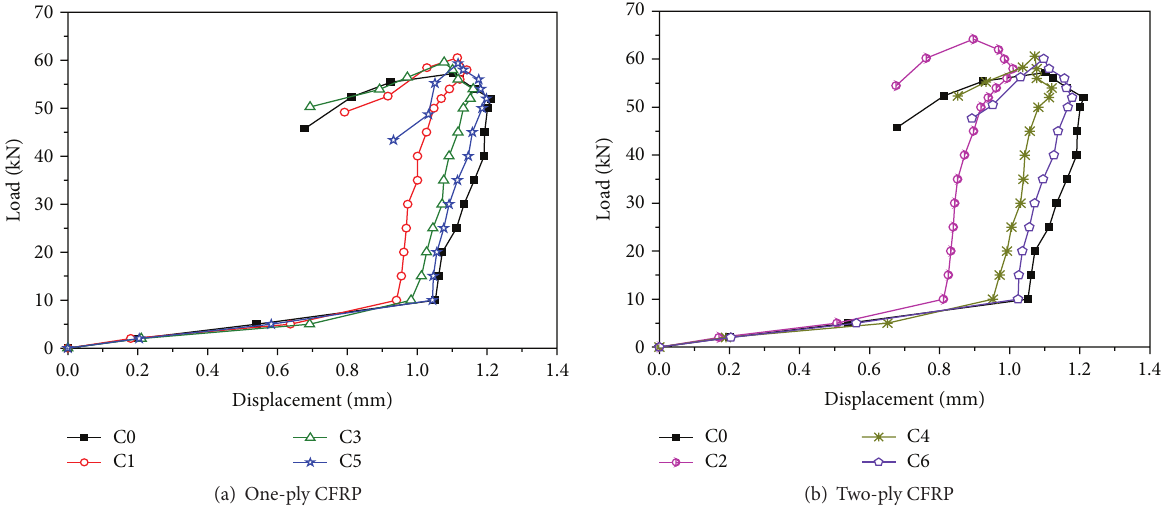
Figure 7: Flange load-deformation